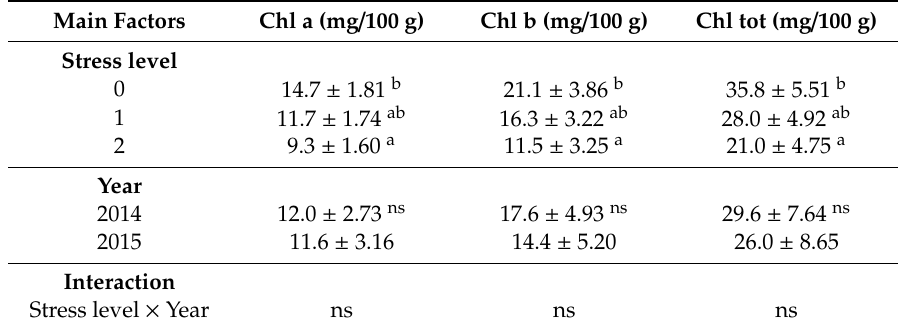
Table 2. E ff ect of water stress levels and year on chlorophylls content (mg / 100 g). Chl a = chlorophyll